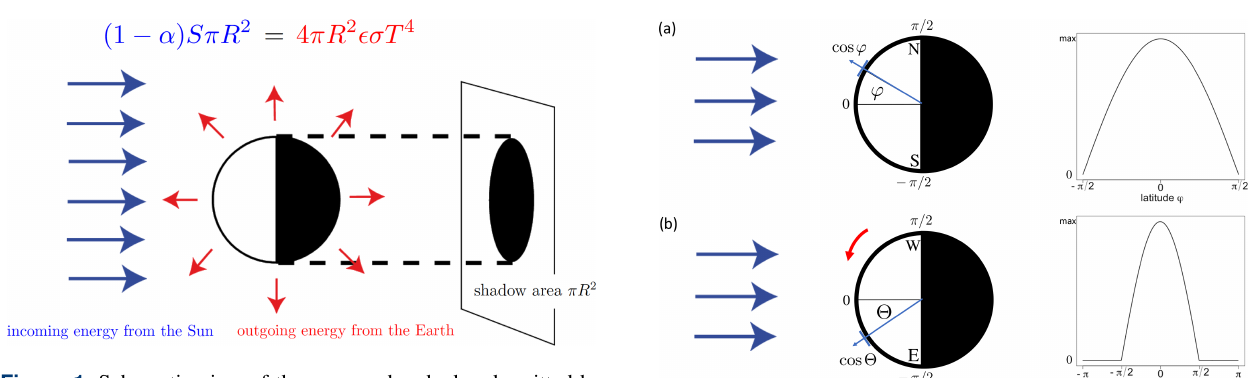
Figure 1. Schematic view of the energy absorbed and emitted by the Earth following Eq. (1). Modified following Goose (2015).